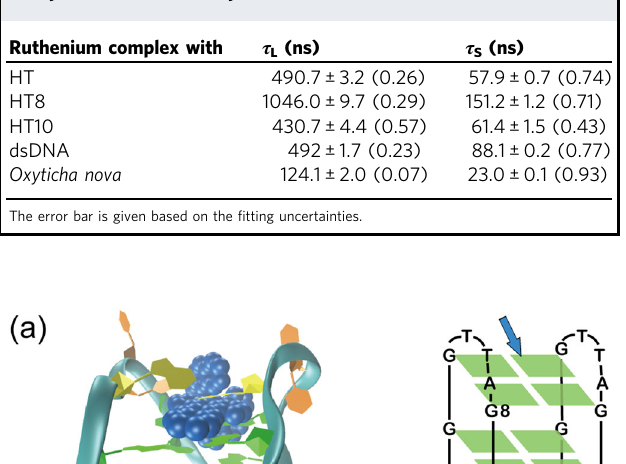
MLCT luminescence lifetimes in HT G-quadruplex are compar- able to those in ds-DNA ( τ L = 492 ns and τ S = 88.1 ns), G-quadruplex core should be similar to its counterpart ds-DNA.